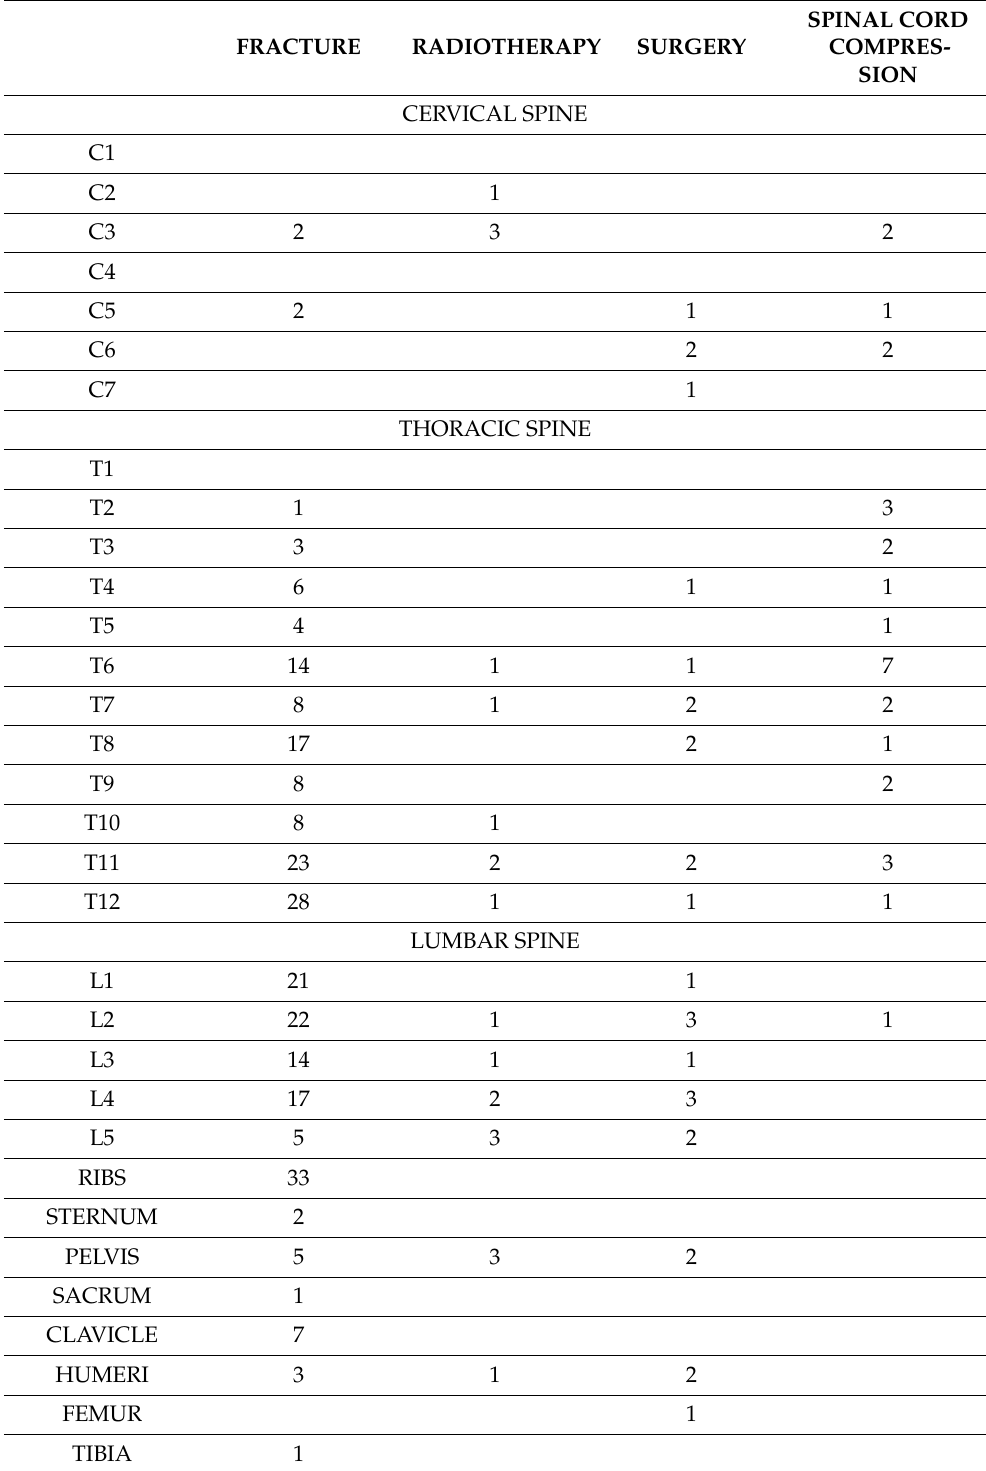
Table 4. Distribution of SREs at